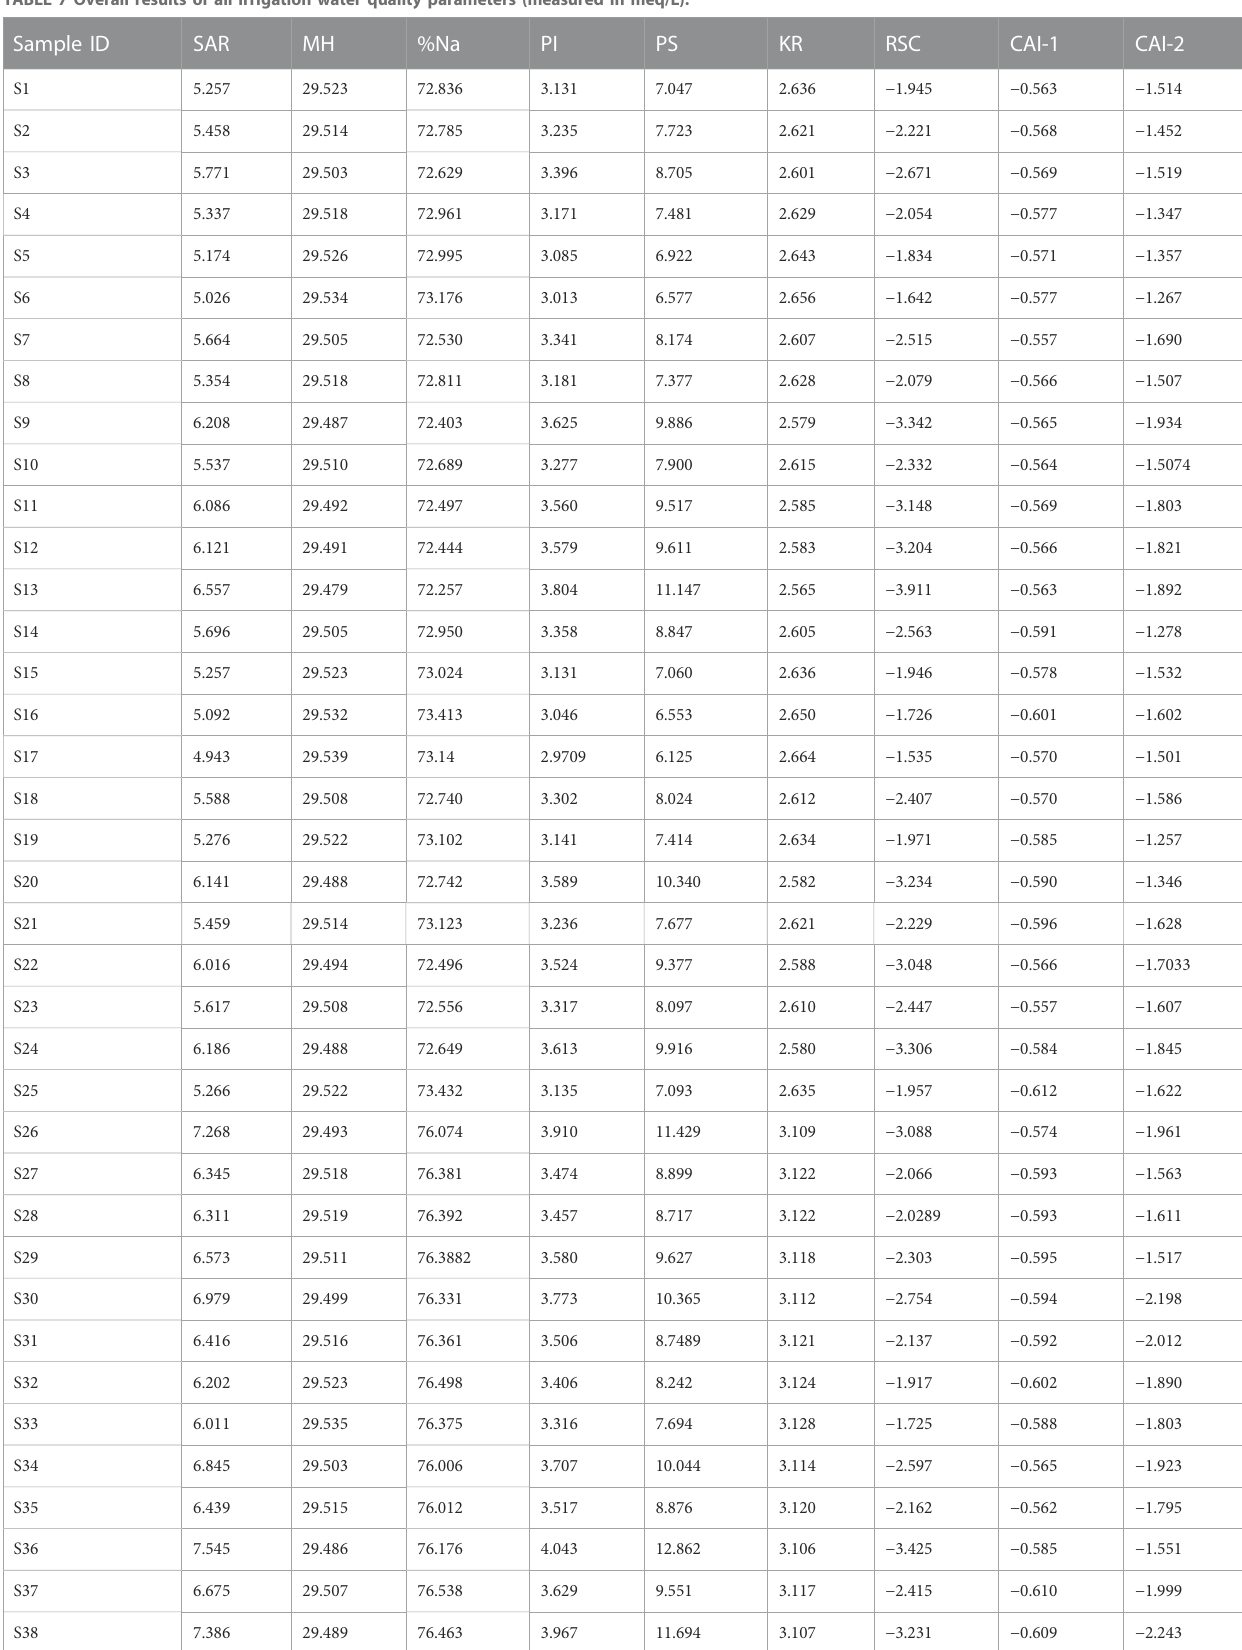
TABLE 7 Overall results of all irrigation water quality parameters (measured in meq/L). Sample